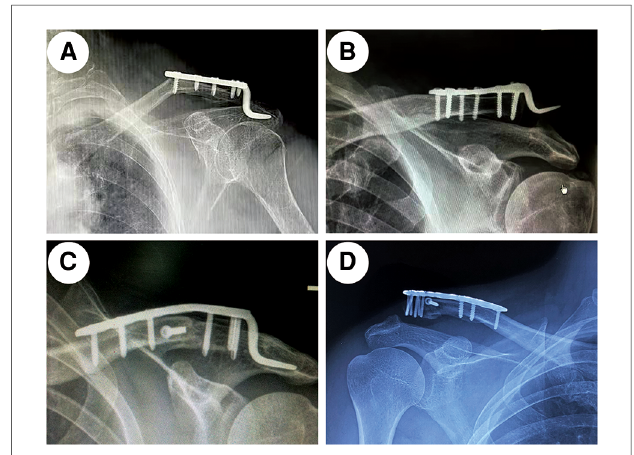
FIGURE 3 The postoperative complications in the HP group and LP group. ( A ) Clavicle shaft fracture, ( B ) dislocation of hook, ( C ) acromial erosion, and ( D ) acromioclavicular joint dislocation. HP, hook plate; LP, locking